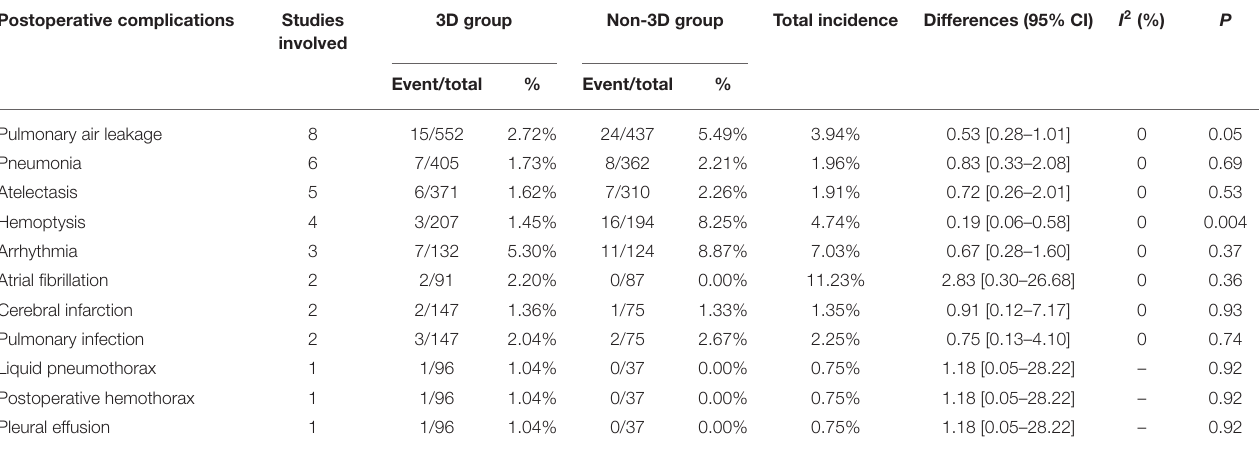
TABLE 3 | Postoperative